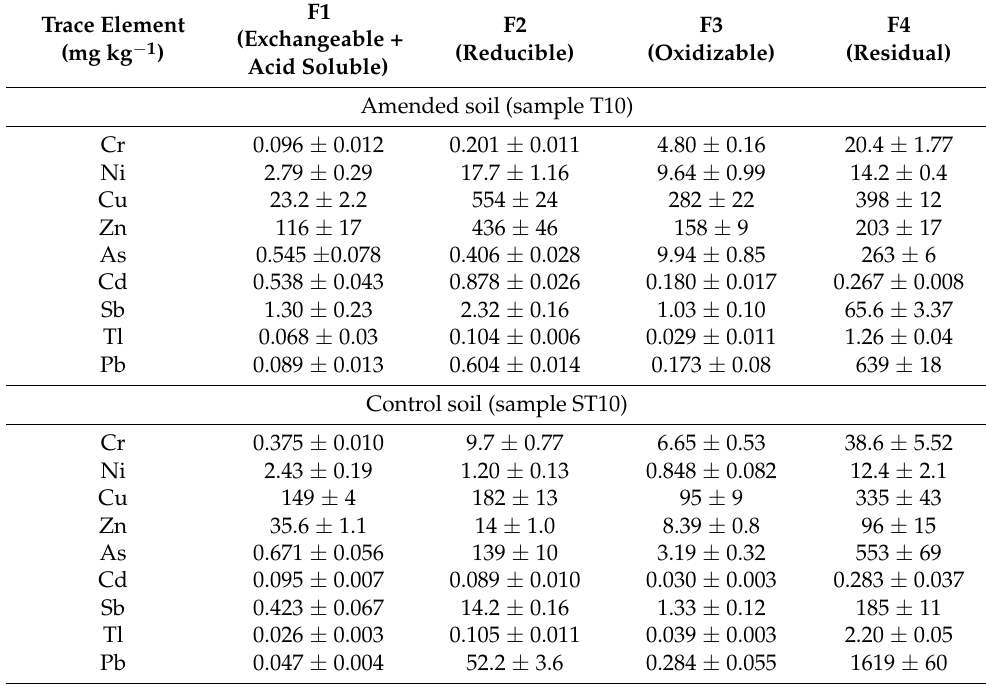
Table 3. Total trace element concentrations (in mg kg − 1 ) analyzed by ICP-OES. Trace